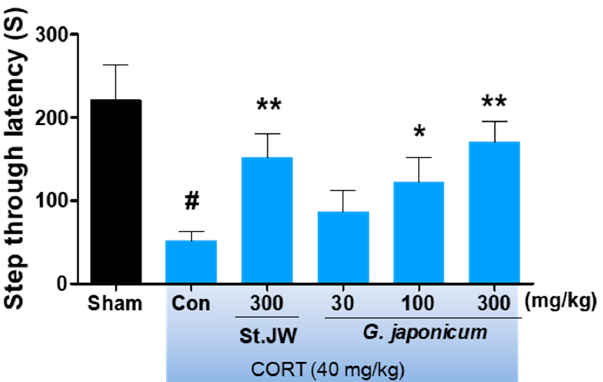
Figure 4. Effects of G. japonicum extract on the passive avoidance test in CORT-induced depressive mice. CORT injections significantly decreased step-through latency time (s), while treatment with 100 and 300 mg / kg G. japonicum extract significantly increased it. Results are presented as mean ± SEM. # p < 0.05 versus the sham group; ** p < 0.01 and * p < 0.05 versus the CORT-injected control group